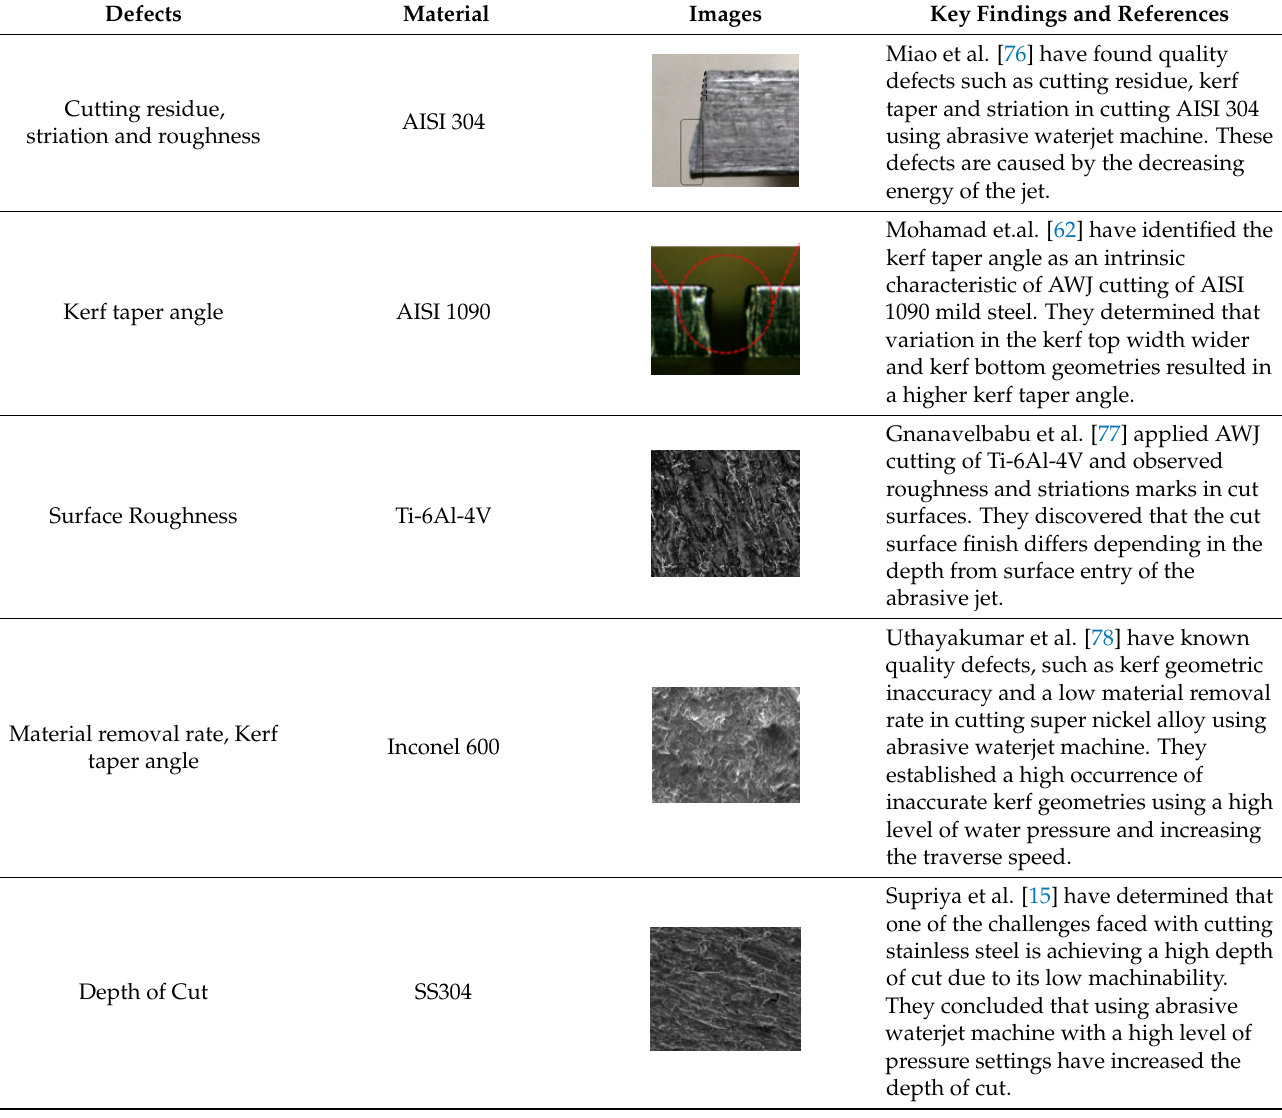
Table 3. AWJ cutting defects amongst various metallic materials [15,62,76–78].